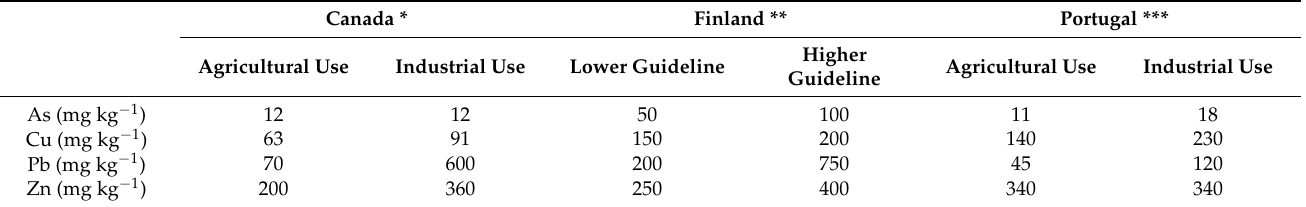
Table 1. Limit values to assess contaminated soils proposed for Portugal and for other countries, as examples (Canada and Finland). Arsenic, Cu, Pb and Zn were selected, the PTEs usually affecting the IPB